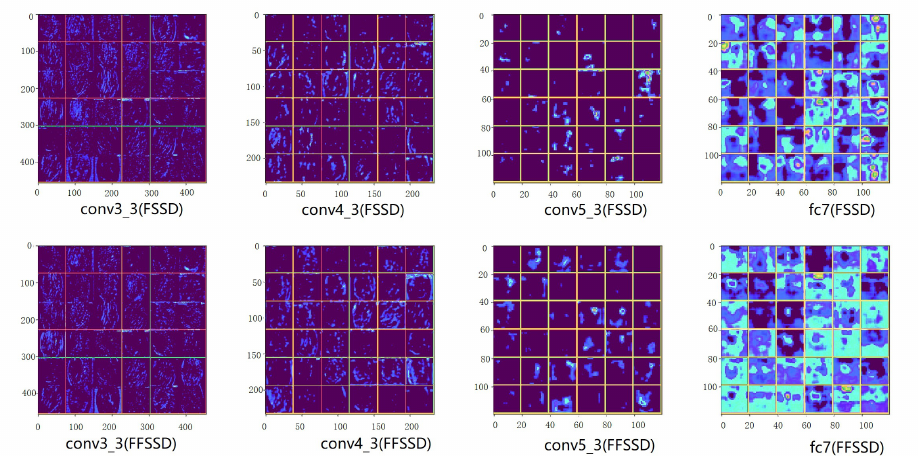
Figure 11. Feature visualization comparison of conv3_3, conv4_3, conv5_3, and fc7 features of the convolution layer of FSSD and